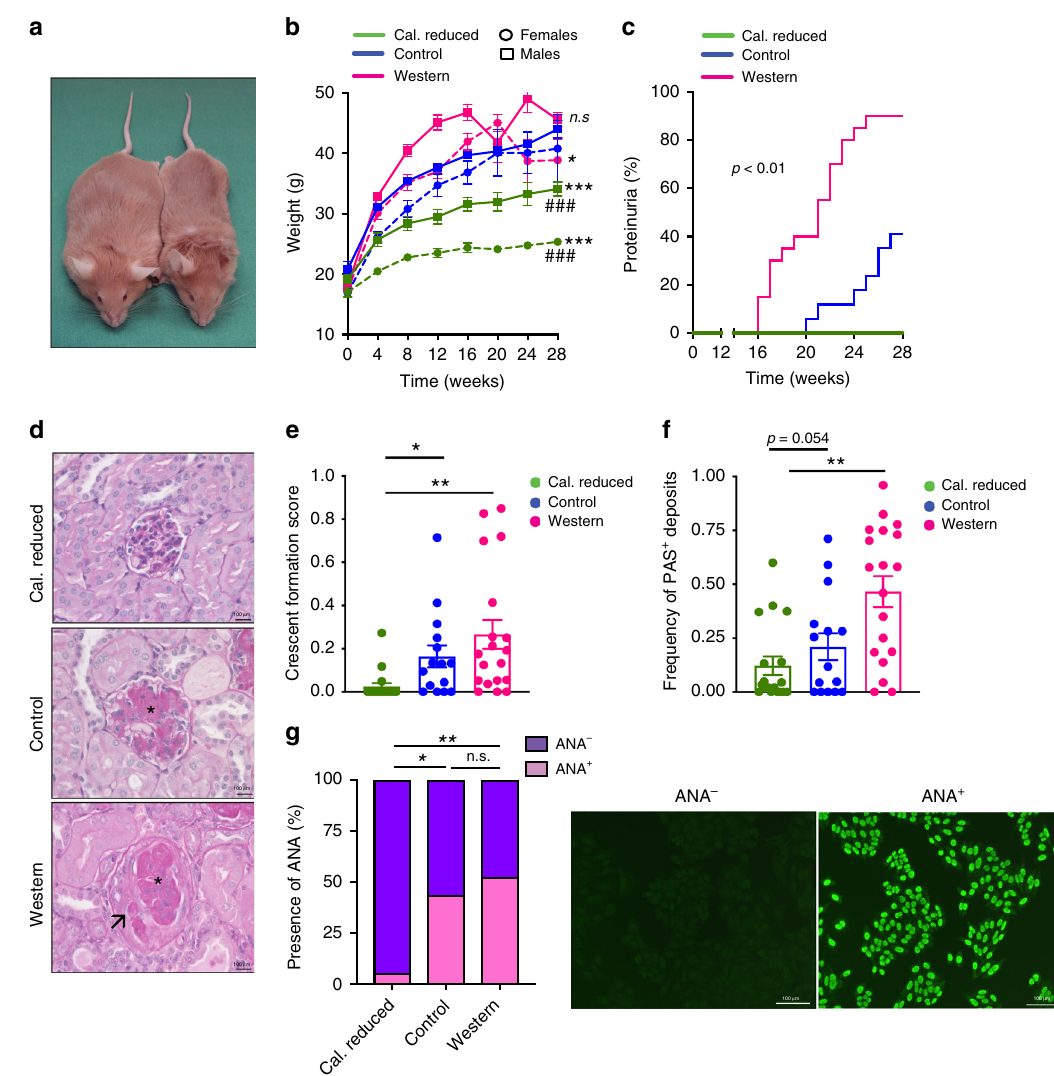
Fig. 2 Impact of diet on development of lupus nephritis in NZM2410/J mice. a Representative image of NZM2410/J mouse exposed to Western diet (left) vs. a mouse fed with calorie-restricted diet (right) after 28 weeks of dietary intervention. b X-Y plot demonstrating the impact of diet and sex on body weight for caloric restriction ( n females = 8, n males = 10), for control diet ( n females = 7, n males = 10) and for western diet ( n females = 9, n males = 11). Error bars indicate means ± SEM. Data was analyzed using two-way ANOVA followed by Tukey ’ s multiple comparison test, * p < 0.05, *** p < 0.001, n.s., not signi fi cant. All were evaluated in comparison to mice on control diet. ### p < 0.001 compared with mice on Western diet. c Step plot showing the onset